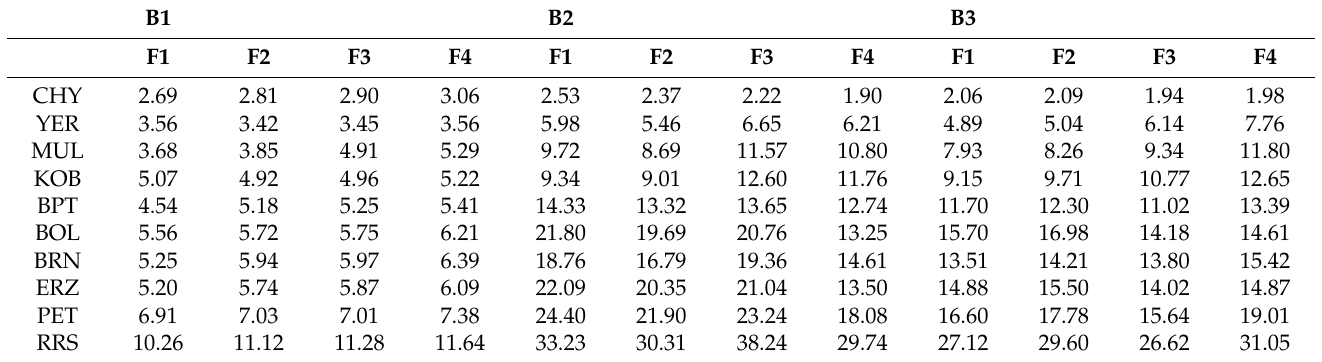
Table 8. Repair Time